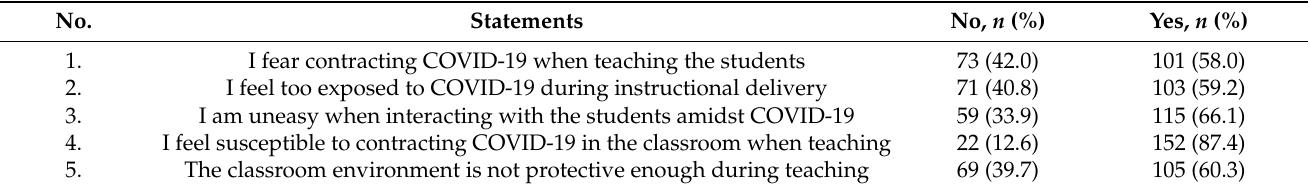
Table 1. Teacher responses on their perception of classroom safety during